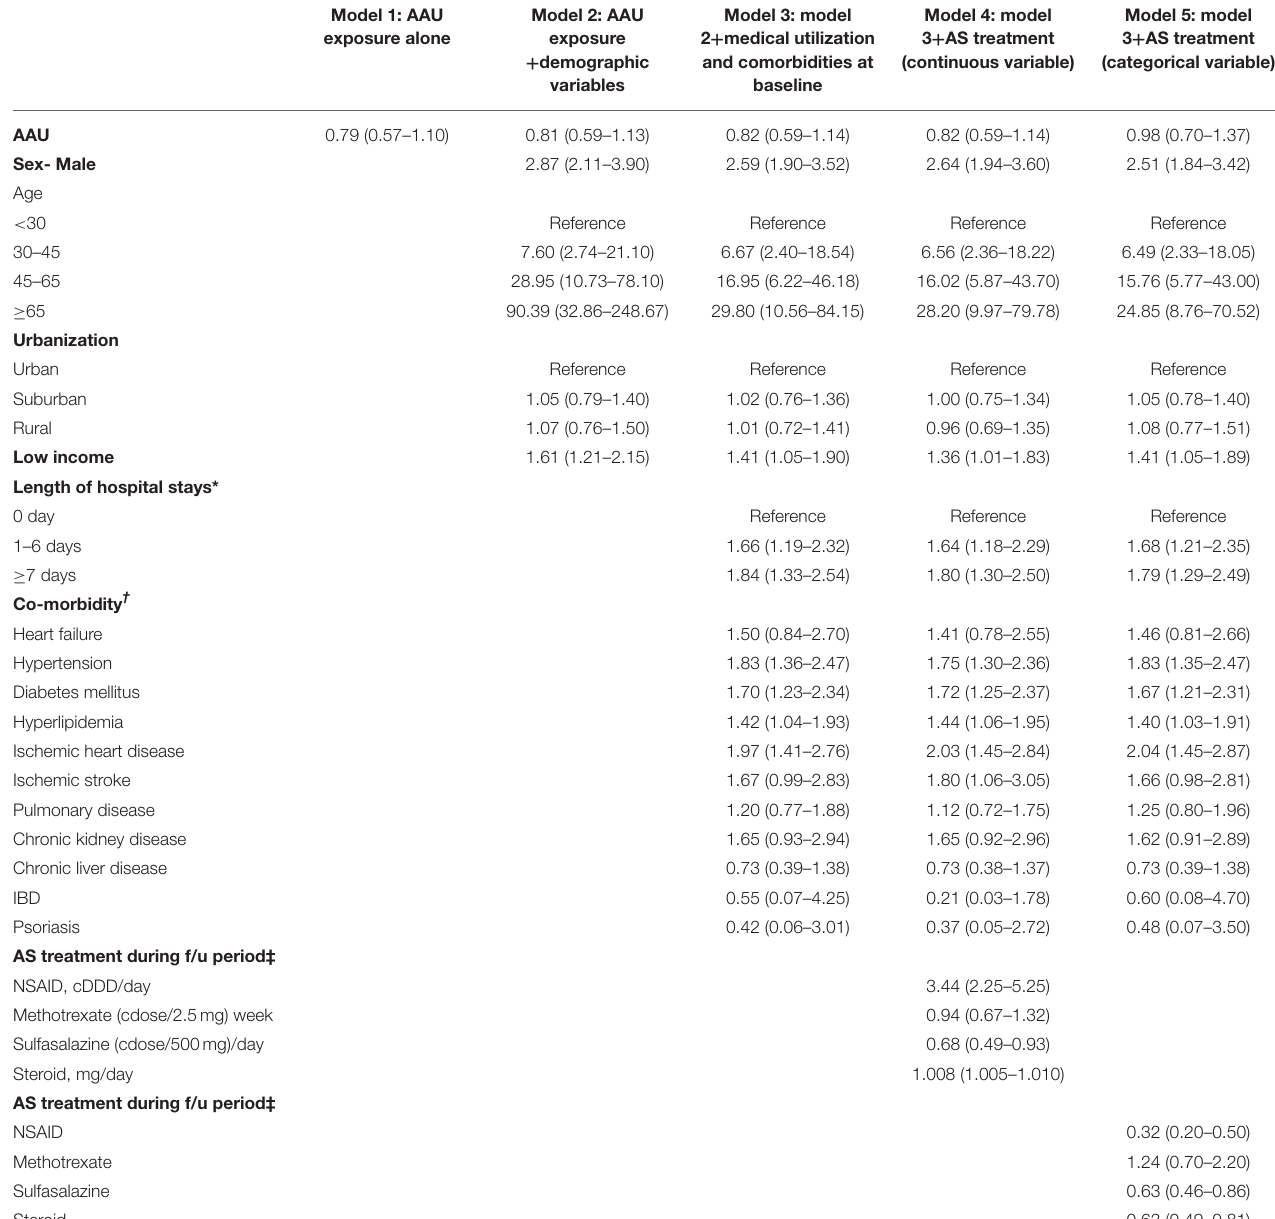
TABLE 3 | Cox proportional hazard regressions for 1:4 age-matched and sex-matched population estimation of adjusted HRs on